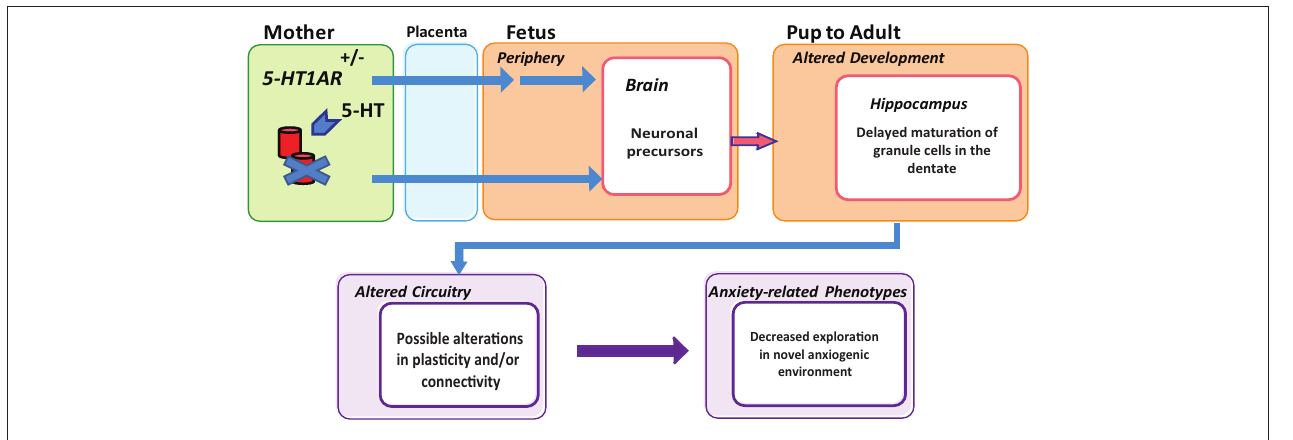
Figure 2 | Schematic showing how prenatal maternal 5-HT1A receptor deficiency may lead to alterations in offspring hippocampal development and increased anxiety-related behavior. 5-HT1A receptor deficiency in the mouse mother is signaled across the placenta during embryonic development